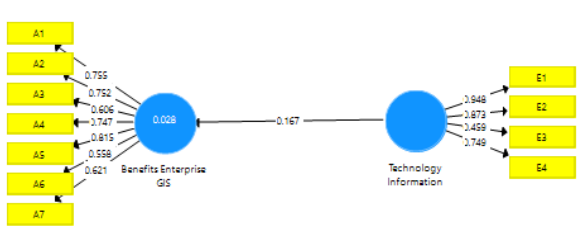
Figure 6. PLS SEM conceptual model for Technology